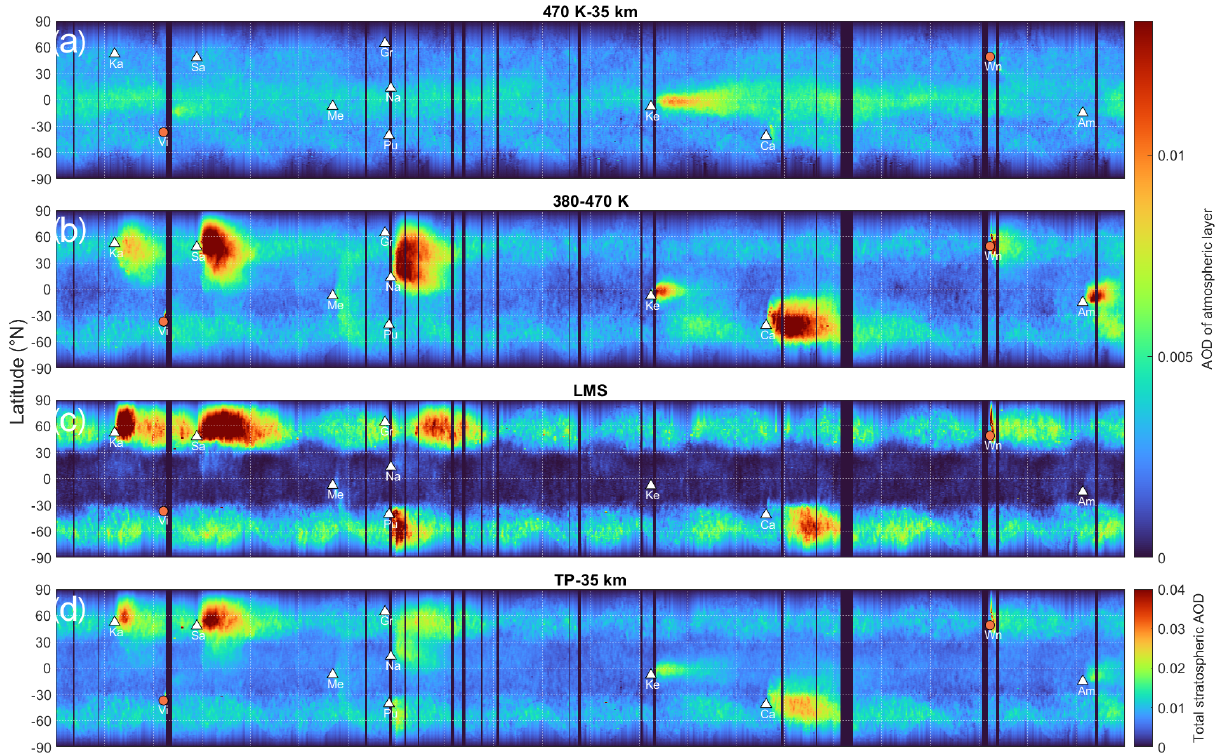
Figure 8. Zonally and 8d moving-average aerosol optical depth (AOD) of the stratosphere. (a–c) AOD in three layers obtained from CALIOP data (level 1B): (a) 470K potential temperature to 35km (deep Brewer–Dobson branch), (b) 380–470K (shallow Brewer–Dobson branch), and (c) the tropopause to 380K (LMS). (d) The total AOD from the tropopause to 35km altitude. Volcanic eruptions are marked by white triangles – Kasatochi (Ka), Sarychev (Sa), Merapi (Me), Grimsvötn (Gr), Puyehue-Cordón Caulle (Pu), Nabro (Na), Kelut (Ke), Calbuco (Ca), and Ambae (Am) – and wildfires are marked by orange circles – Victoria fire (Vi) and western North American fires (Wn) at time and latitude of eruption/fire. The AODs are corrected for attenuation.